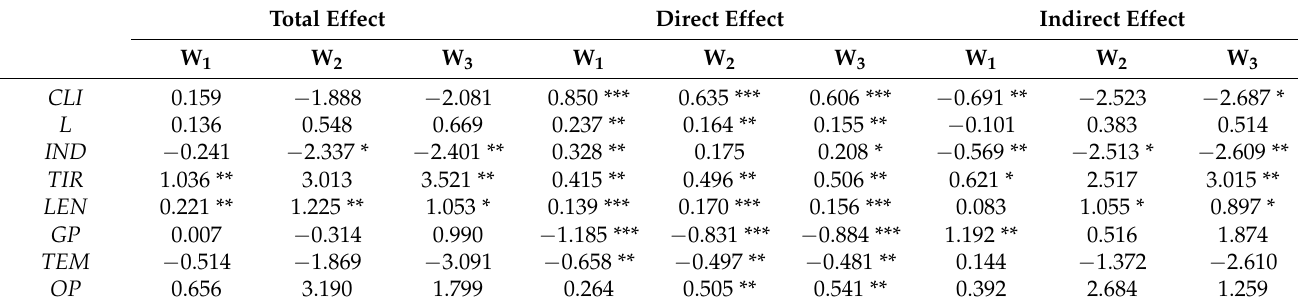
Table 3. Spatial effect decomposition of the Spatial Durbin